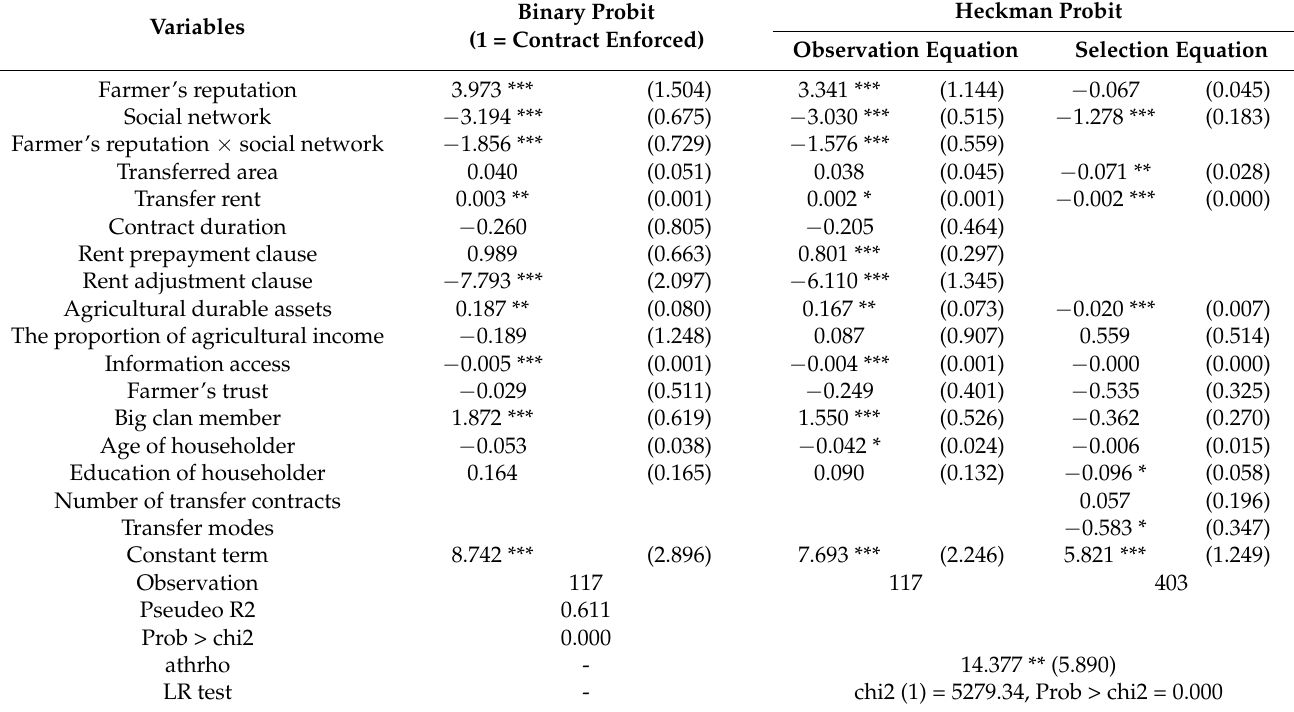
Table 6. The results of informal contract self-enforcement